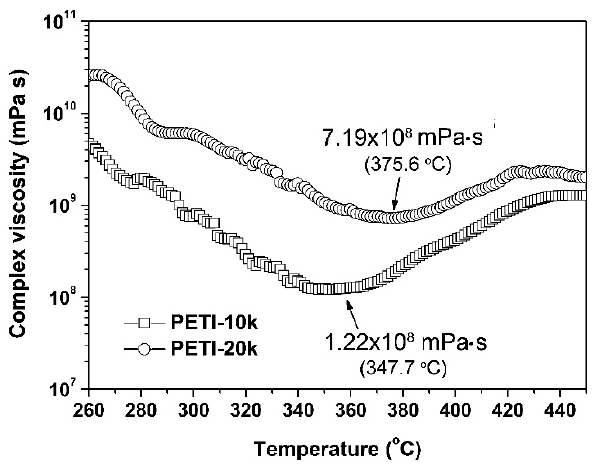
Figure 9. Rheological plots of phenylethynyl ‐ terminated PI resins in nitrogen.